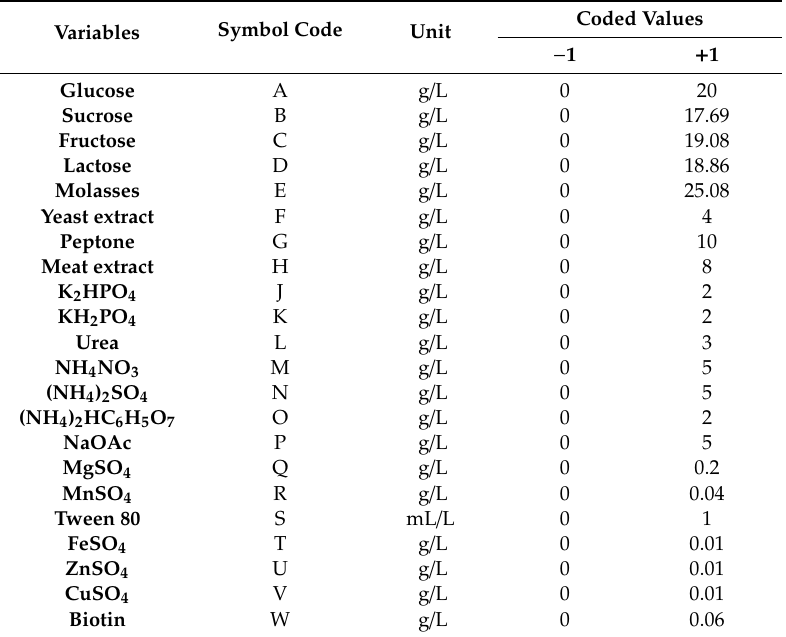
Coded and real values of variables selected in PBD for tryptophan production by P. acidilactici TP-6.